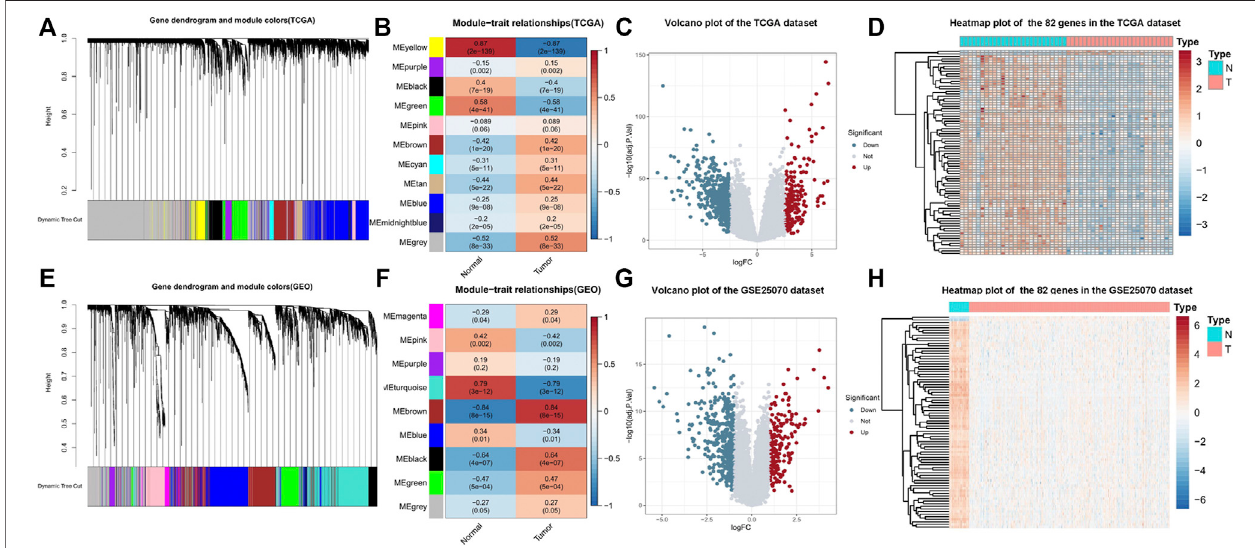
FIGURE2|(A) InTCGA COAD-READ dataset, thedendrogramsofall differentially expressed genes wereclusteredbasedon the measurement ofdissimilarity (1- TOM).Each module wasassigned acolor. (B) In TCGA COAD-READ dataset, module-trait relationships. Each row corresponds toamodule feature gene (ME), and the column corresponds to a feature. Each cell contains the corresponding correlation and the p value. (C) Volcano plot of DEGs from TCGA. (D) Heatmap of 82 genes in TCGA dataset. (E) In the GSE25070 dataset, the dendrograms of all differentially expressed genes were clustered based on the measurement of dissimilarity (1- TOM). Each module was assigned a color. (F) In the GSE25070 dataset, module-trait relationships. Each row corresponds to a module feature gene (ME), and the columncorrespondstoafeature.Eachcellcontainsthecorrespondingcorrelationandthe p value (G) VolcanoplotofDEGsfromtheGSE25070dataset. (H) Heatmapof the 82 genes in the GSE25070